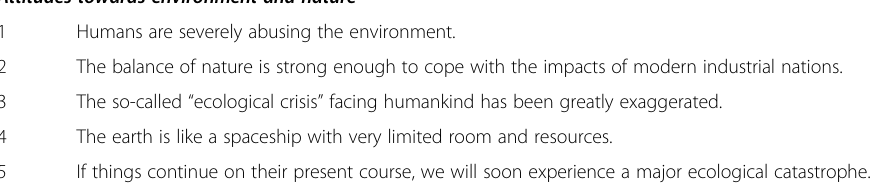
Table 1 Attitudinal scales Attitudes towards environment and